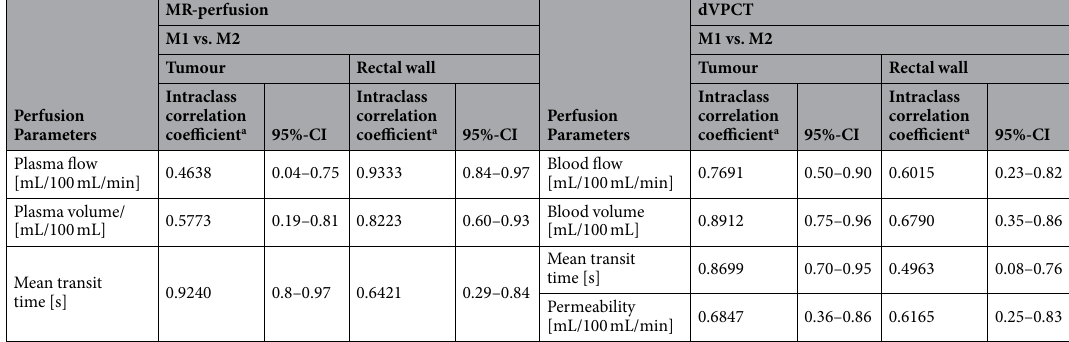
Table 3. Assessment of Intra-reader variability of MR-Perfusion and dVPCT – Intraclass correlation coefficient analysis. a Estimates the reliability of single ratings. CI = confidence